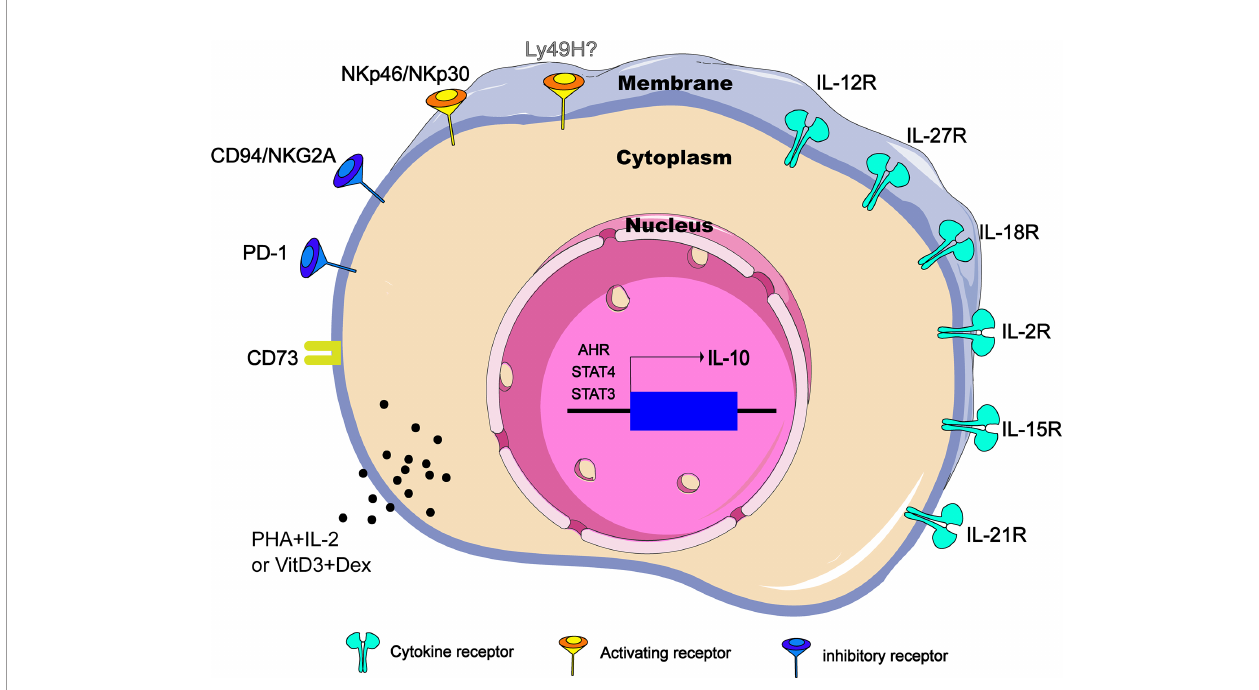
FIGURE 1 | Regulators of IL-10 expression in NK cells. IL-10-producing NK cells can be induced and regulated through different mechanisms, including extracellular chemical factors, cytokine and membrane proteins that trigger signaling, and transcription factors in the nucleus. CD73 is ecto-5 ’ -nucleotidase molecules encoded by NT5E gene. PHA, phytohemagglutinin; VitD3, vitamin D3; Dex,